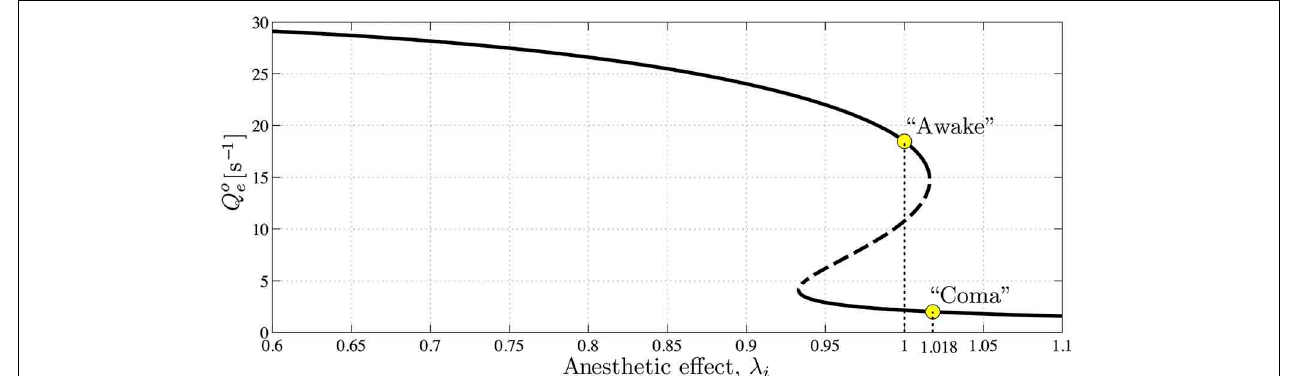
FIGURE 8 | The steady-state firing rates Q o e as a function of varying anesthetic inhibition λ i at a particular cortical excitation. The upper, high-firing and lower, low-firing branches (solid curve) are considered to be “awake” and “coma” states, respectively, with the “coma” state being associated with anesthetic-induced unconsciousness. Dashed